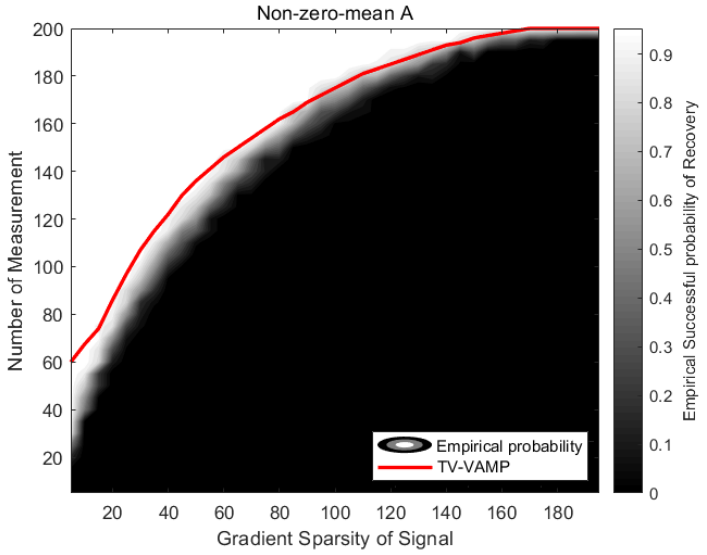
Figure 6. The figure shows phase transitions of CVX and TV-VAMP algorithm in the case of µ = 1 and n = 200.